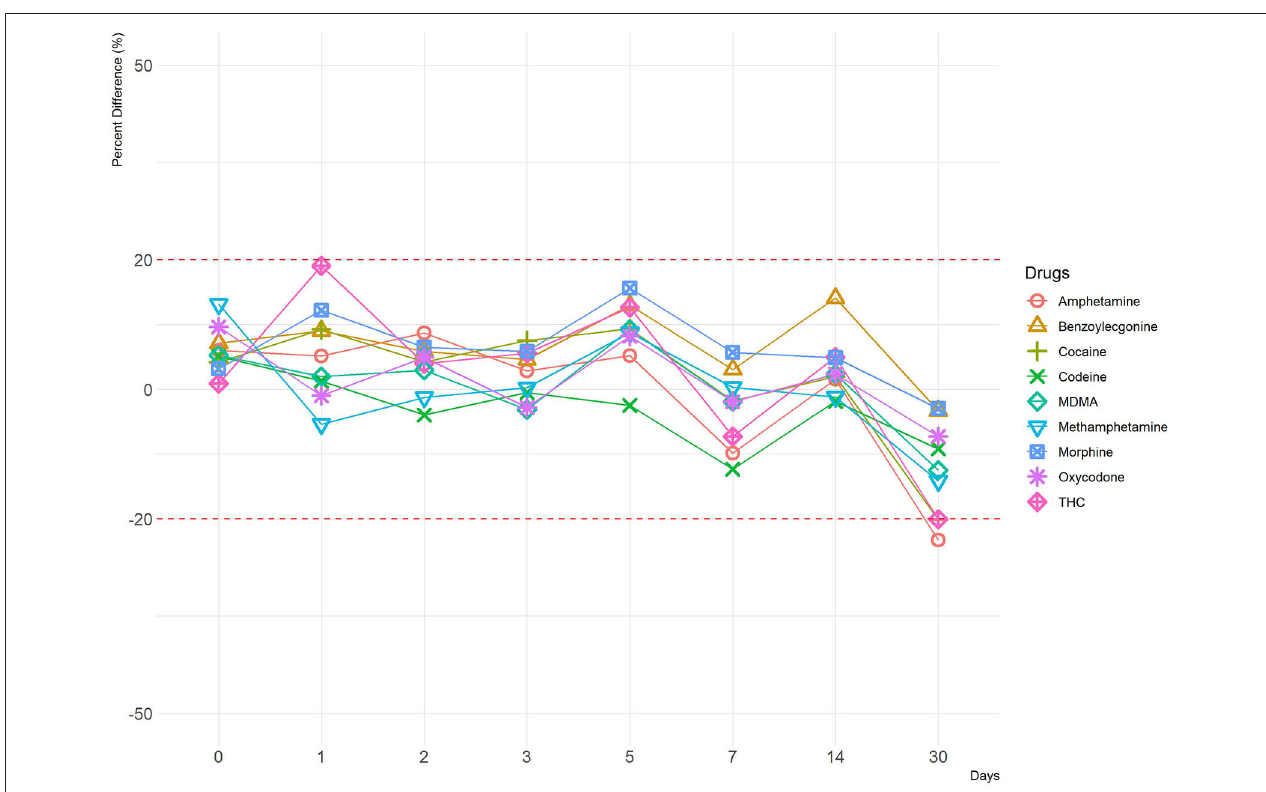
FIGURE 3 | A line plot depicting percentage difference at 4 ◦ C (–50% cut-off). The y-axis represents percentage difference, and the x-axis represents time points in days. Red dotted lines represent ± 20% cut-off.